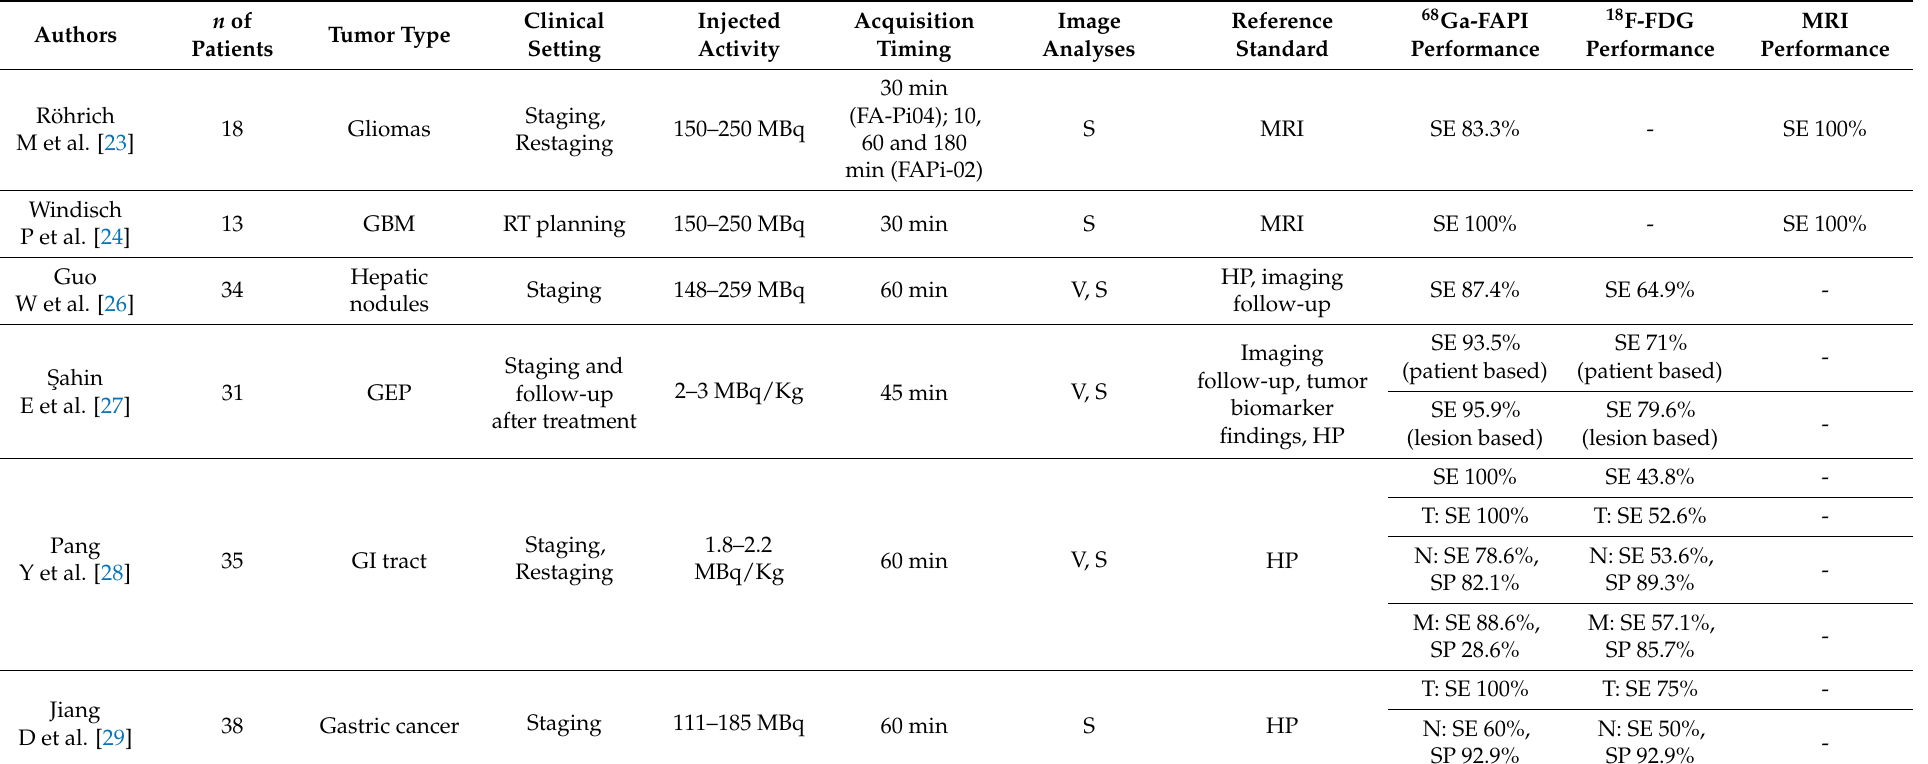
Table 2. Oncological setting: Gliomas, primary liver cancer and gastro-entero-pancreatic